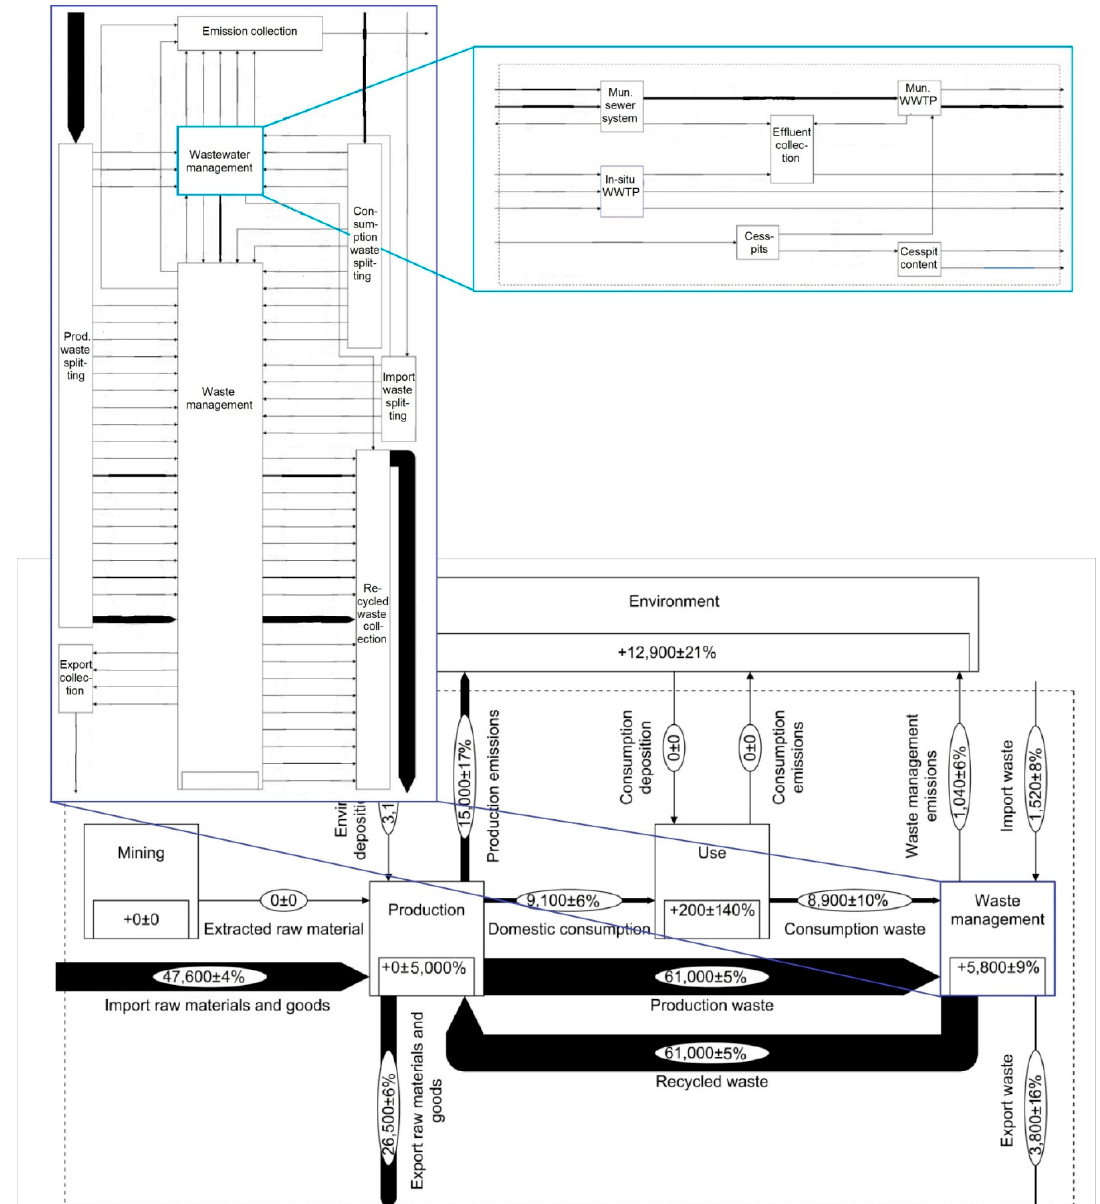
Figure 6. Cascade of subsystems. Example from the Austrian P system 2015.